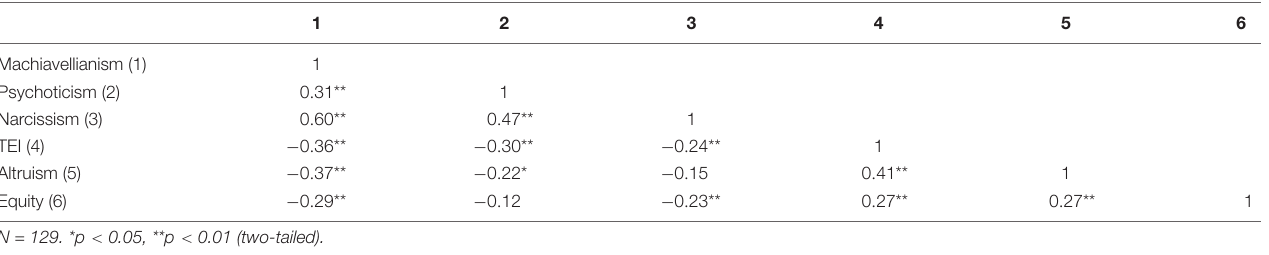
TABLE 2 | Correlations among study variables.